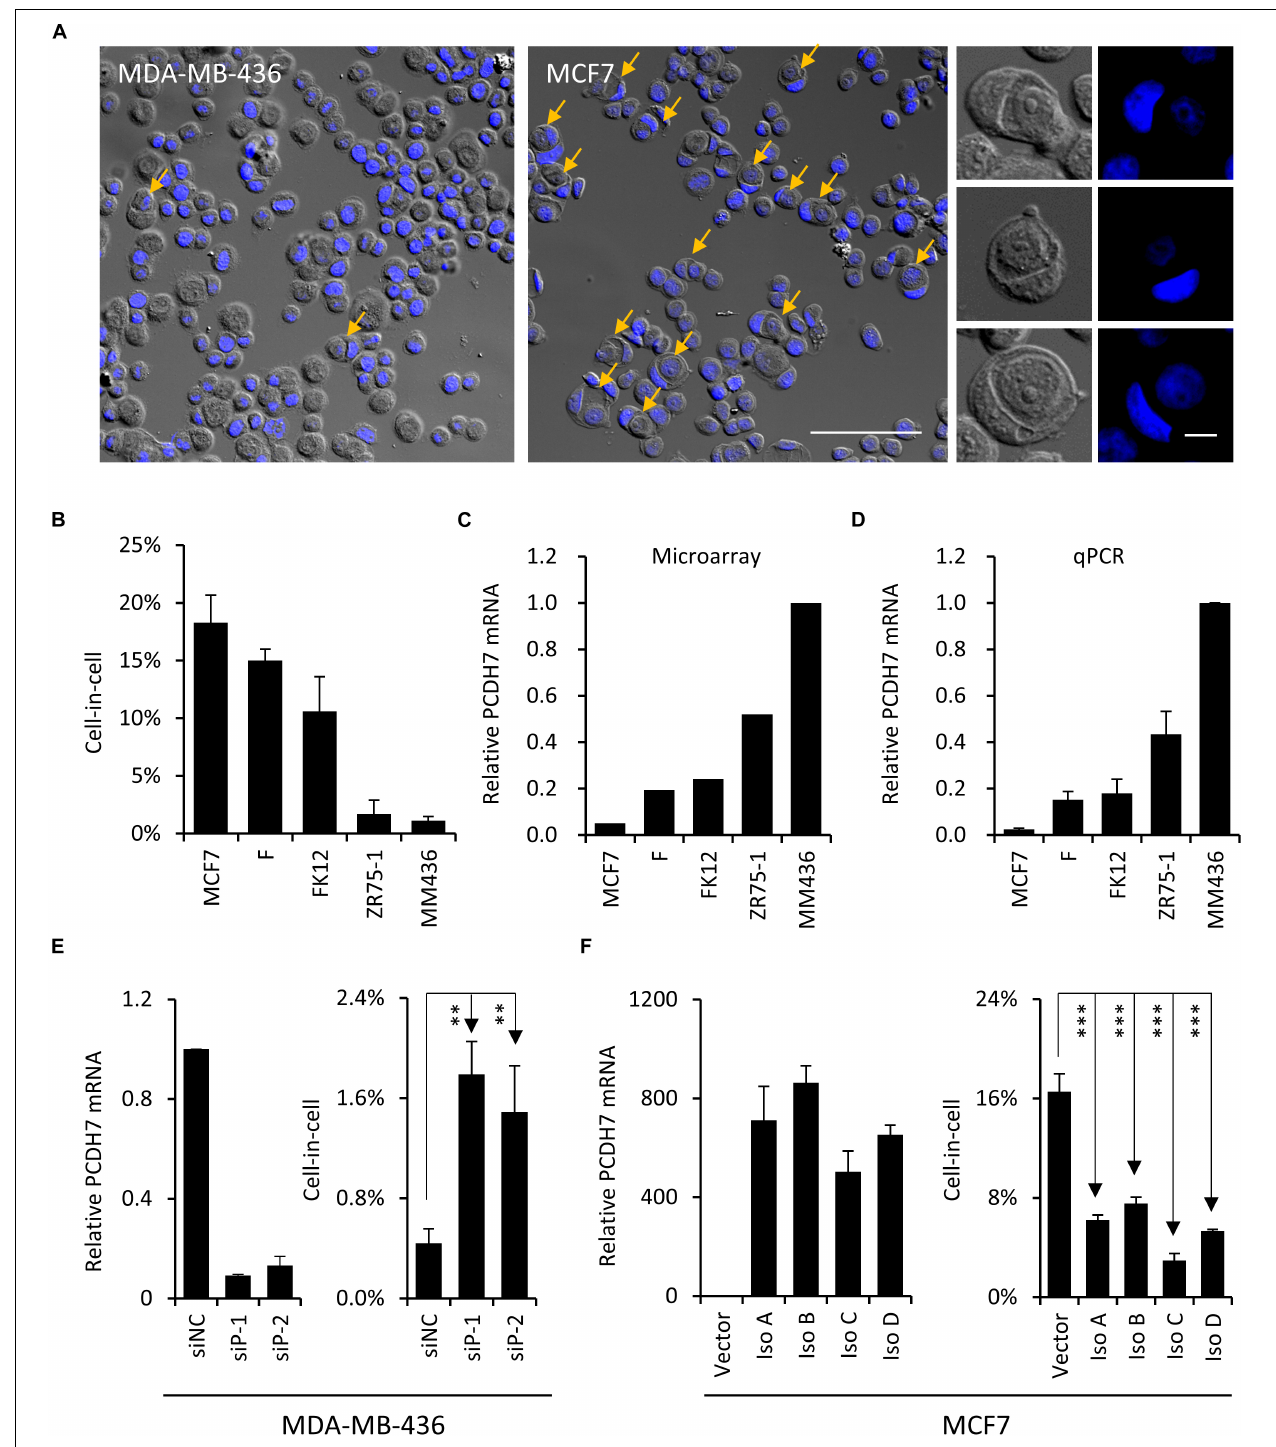
FIGURE 1 | PCDH7 inhibits homotypic cell-in-cell formation. (A) Representative cytospin images for MCF7 and MDA-MB-436 cells. Representative images for typical CIC structures of different stages are shown in right. Yellow arrows indicate hoCIC. The nuclei were stained with DAPI (blue). Scale bar: 100 µ m (left) and 10 µ m (right). (B) The frequencies of hoCICs formation in different breast tumor cell lines. Data are mean ± SD of triplicate experiments. (C,D) PCDH7 expression in microarray (C) and determined by quantitative RT-PCR (D) . Data are mean ± SD of triplicate experiments. (E) PCDH7 knock-down (left) results in increased CIC formation (right) in MDA-MB-436 cells. Data are mean ± SD of triplicate experiments. ∗∗ P < 0.01. (F) Overexpression of PCDH7 isoforms (left) inhibits CIC formation (right) in MCF7 cells. Data are mean ± SD of triplicate experiments. ∗∗∗ P < 0.001.